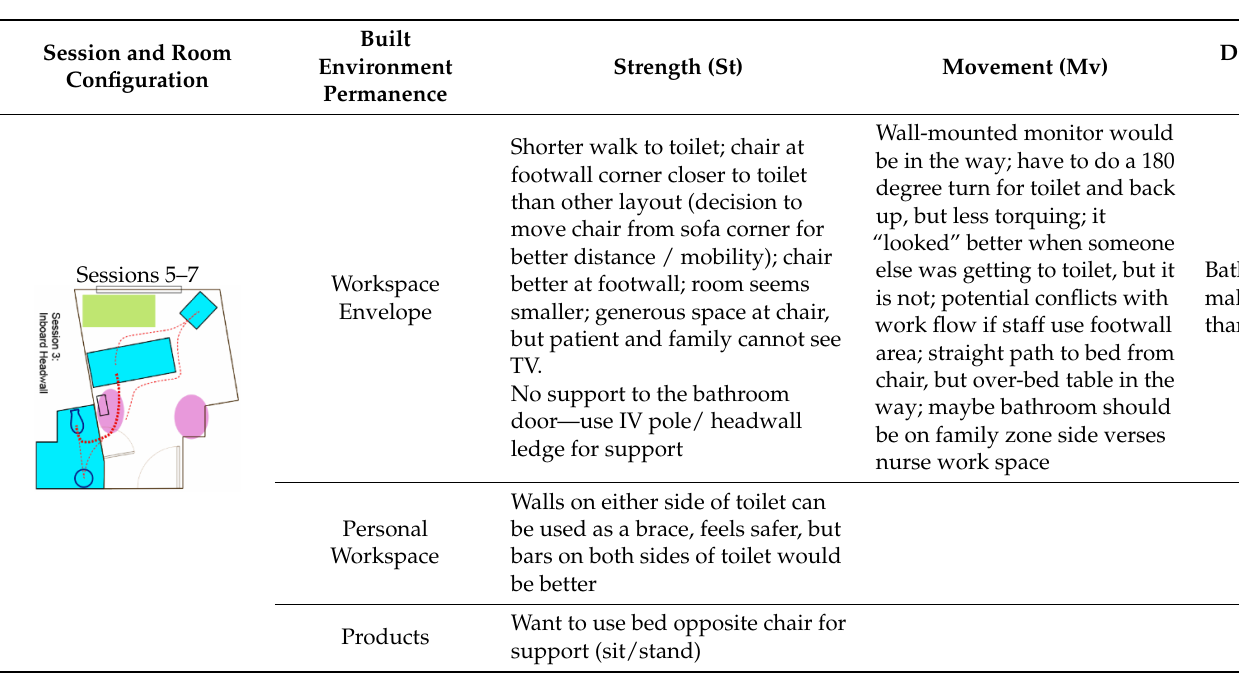
Table 4. Session 5–7 Feedback (Room 3—Inboard